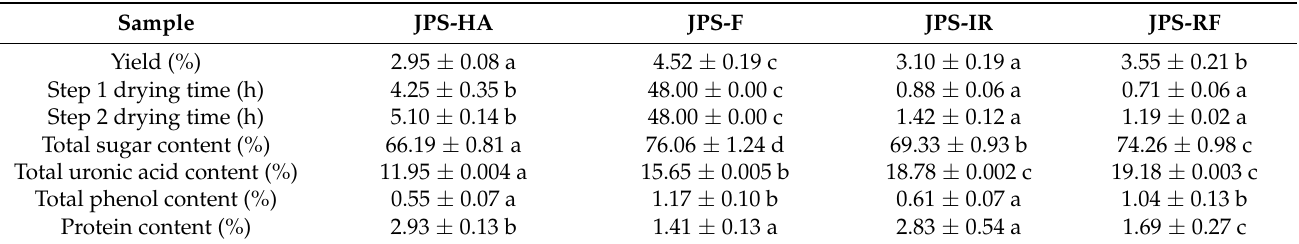
Table 1. Extraction rate, drying duration, and chemical composition of JPSs treated with different drying